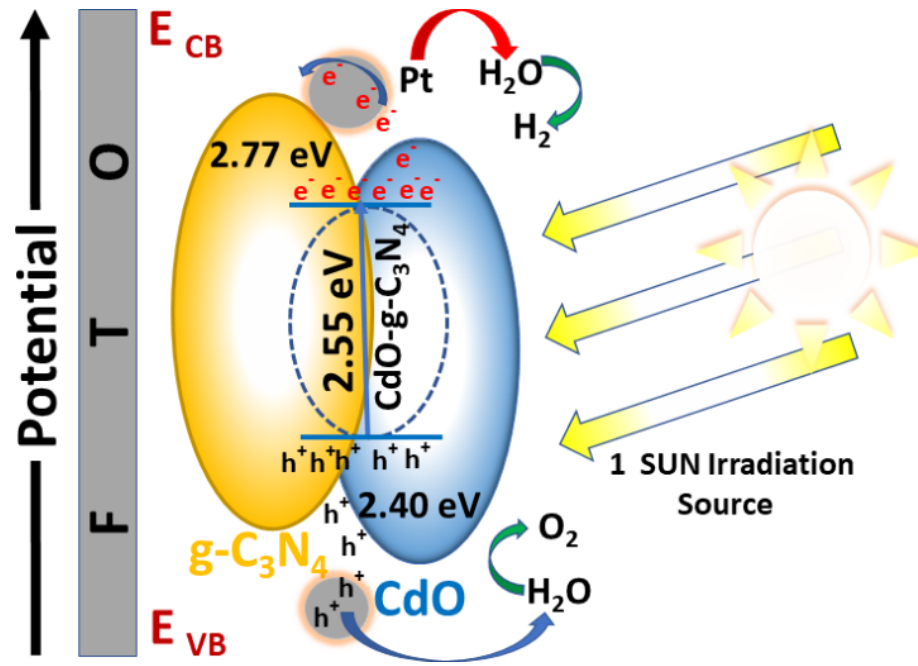
Figure 9. The proposed charge transfer mechanism by g-C 3 N 4 , CdO and CdO-g-C 3 N 4 Photocata- lyst.